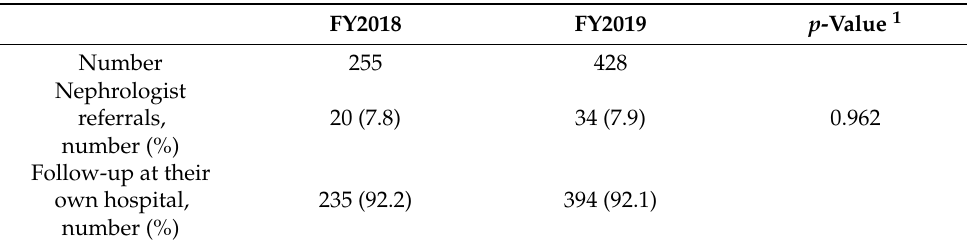
Table 3. Rate of nephrologist referrals for individuals undergoing re-examination.